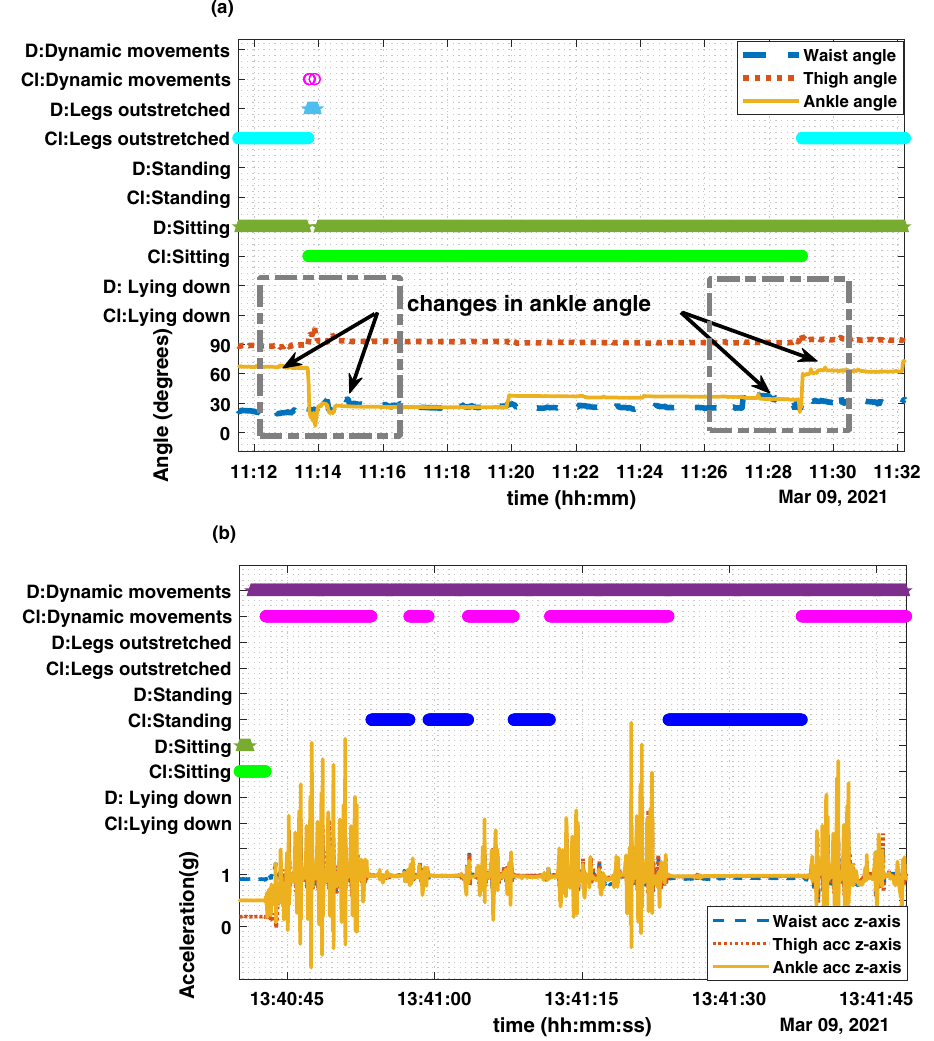
Figure 7. Two segments from Participant A’s Day 2 data with classifier output and diary data. Plot ( a ) shows the sensor to vertical angles of the waist (blue dash), thigh (red dot) and ankle (solid yellow) for a period of ‘sitting’ as per the diary record. The classifier output (Cl) and diary data (D) are shown in the upper part of the graph. The participant has only changed the ankle angle while the waist and thigh remain the same, resulting in the classifier output changing between ‘sitting’ and ‘sitting legs outstretched’. Plot ( b ) shows a period of fidgeting as per the diary data. The z-axis of the accelerometers on the waist (blue dash), thigh (red dot) and ankle (solid yellow) are shown. The classifier classified some segments as standing (shown in blue), while the diary recorded the whole segment as fidgeting